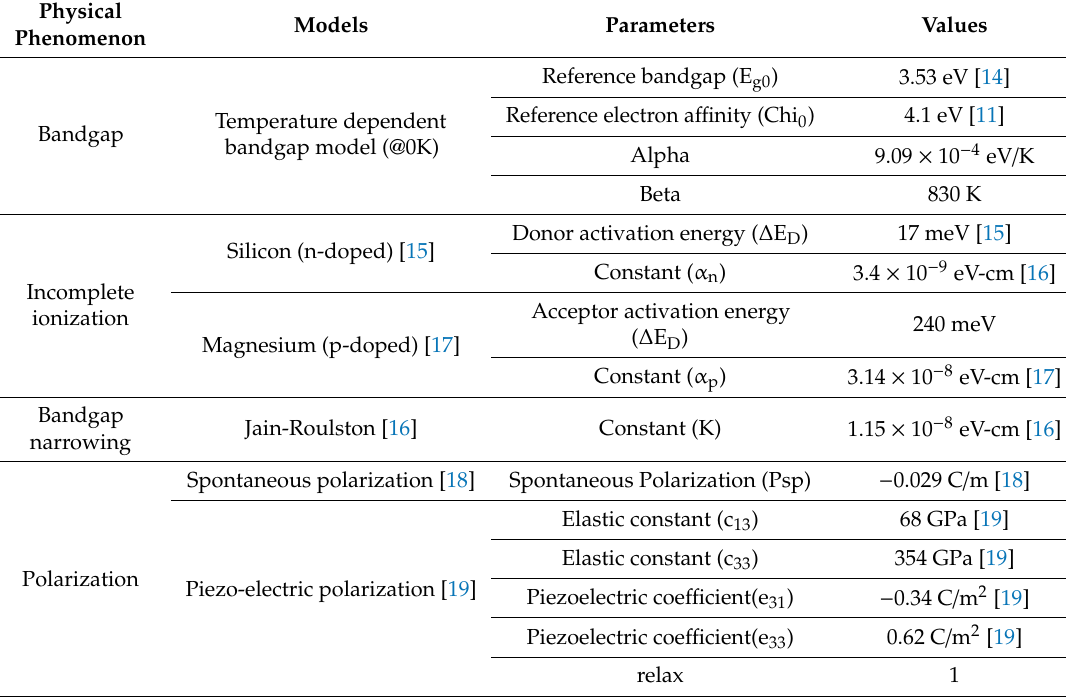
Table 2. The physical models and model